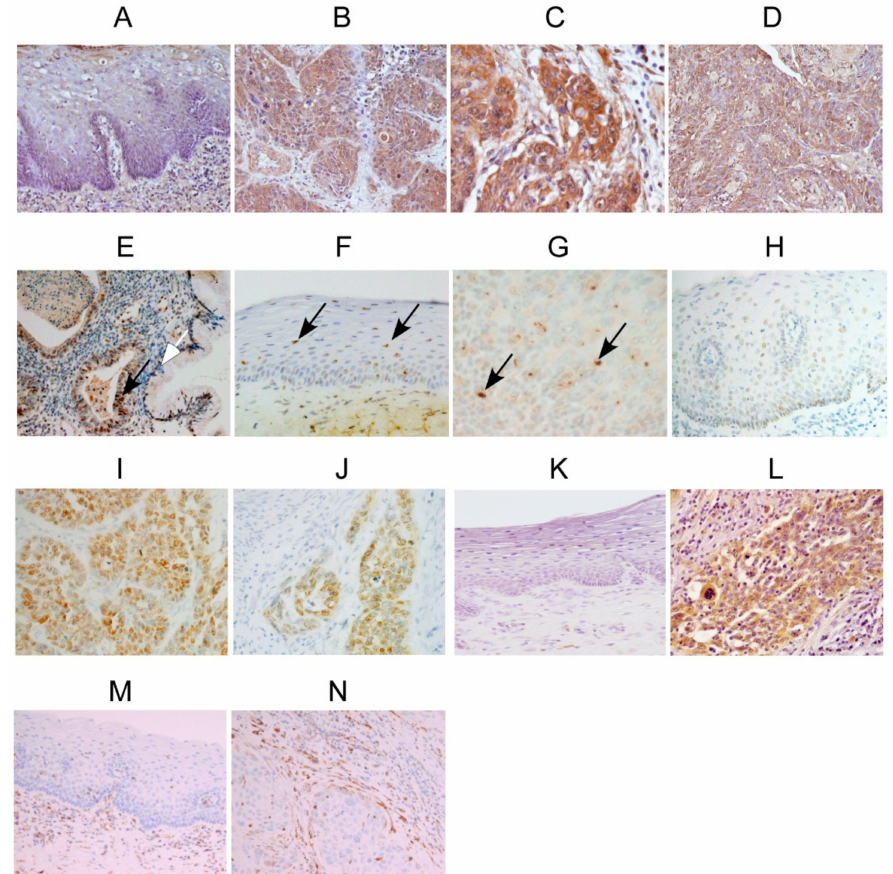
Figure 1. Immunoreactivities of DEC1, DEC2, SOX2, c-MYC and vimentin in cervical cancer tissues. RepresentativeimagesfortheimmunoreactivitiesofDEC1, DEC2, SOX2, c-MYCandvimentinincervical cancer tissues. Each panel shows × 200 magnification. DEC1 immunoreactivities in ( A ) non-cancerous cells, ( B ) shallow cancer cells, and ( C ) deep cancer cells of case 14. DEC1 immunoreactivity in ( D ) SCC of case 1, and in ( E ) AC of case 5, respectively. DEC2 immunoreactivities in ( F ) non-cancerous cells, ( G ) and cancer cells of case 15. SOX2 immunoreactivities in ( H ) non-cancerous cells, ( I ) shallow cancer cells, and ( J ) deep cancer cells of case 14. c-MYC immunoreactivities in ( K ) non-cancerous cells, ( L ) and cancer cells of case 15. Vimentin immunoreactivities in ( M ) non-cancerous vascular cells, ( N ) and cancerous vascular cells of case 14. Black arrows in E-G show nuclear staining. The white arrow in E indicates non-cancerous